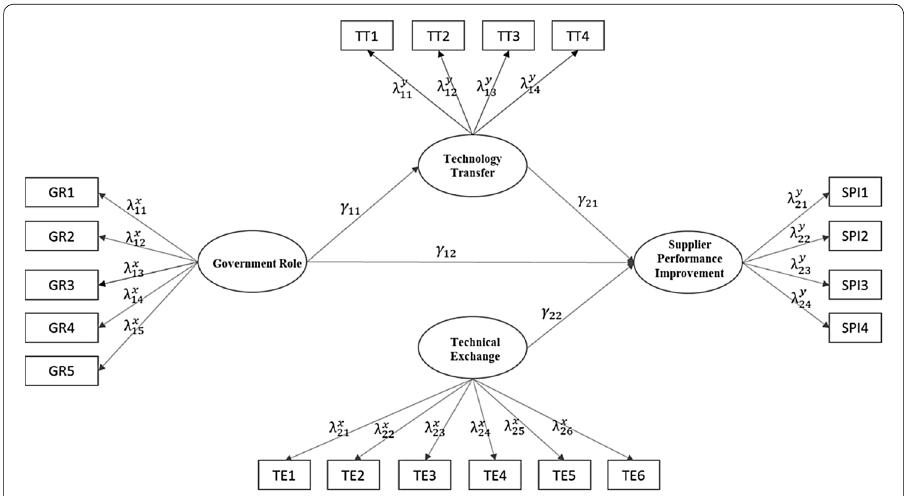
Fig. 5 Structural model and measurement model. Source : Author